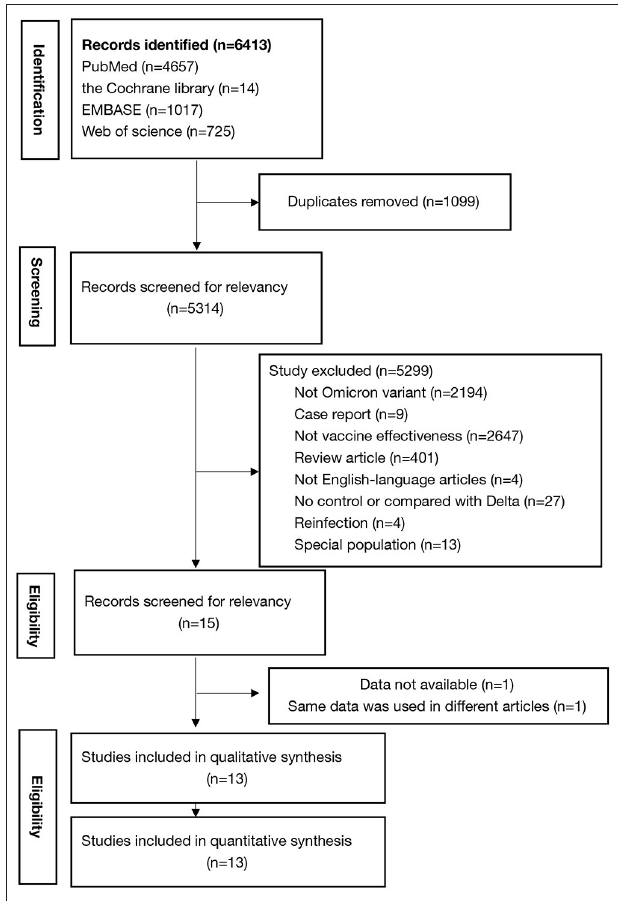
FIGURE 1 | Steps of the study selection